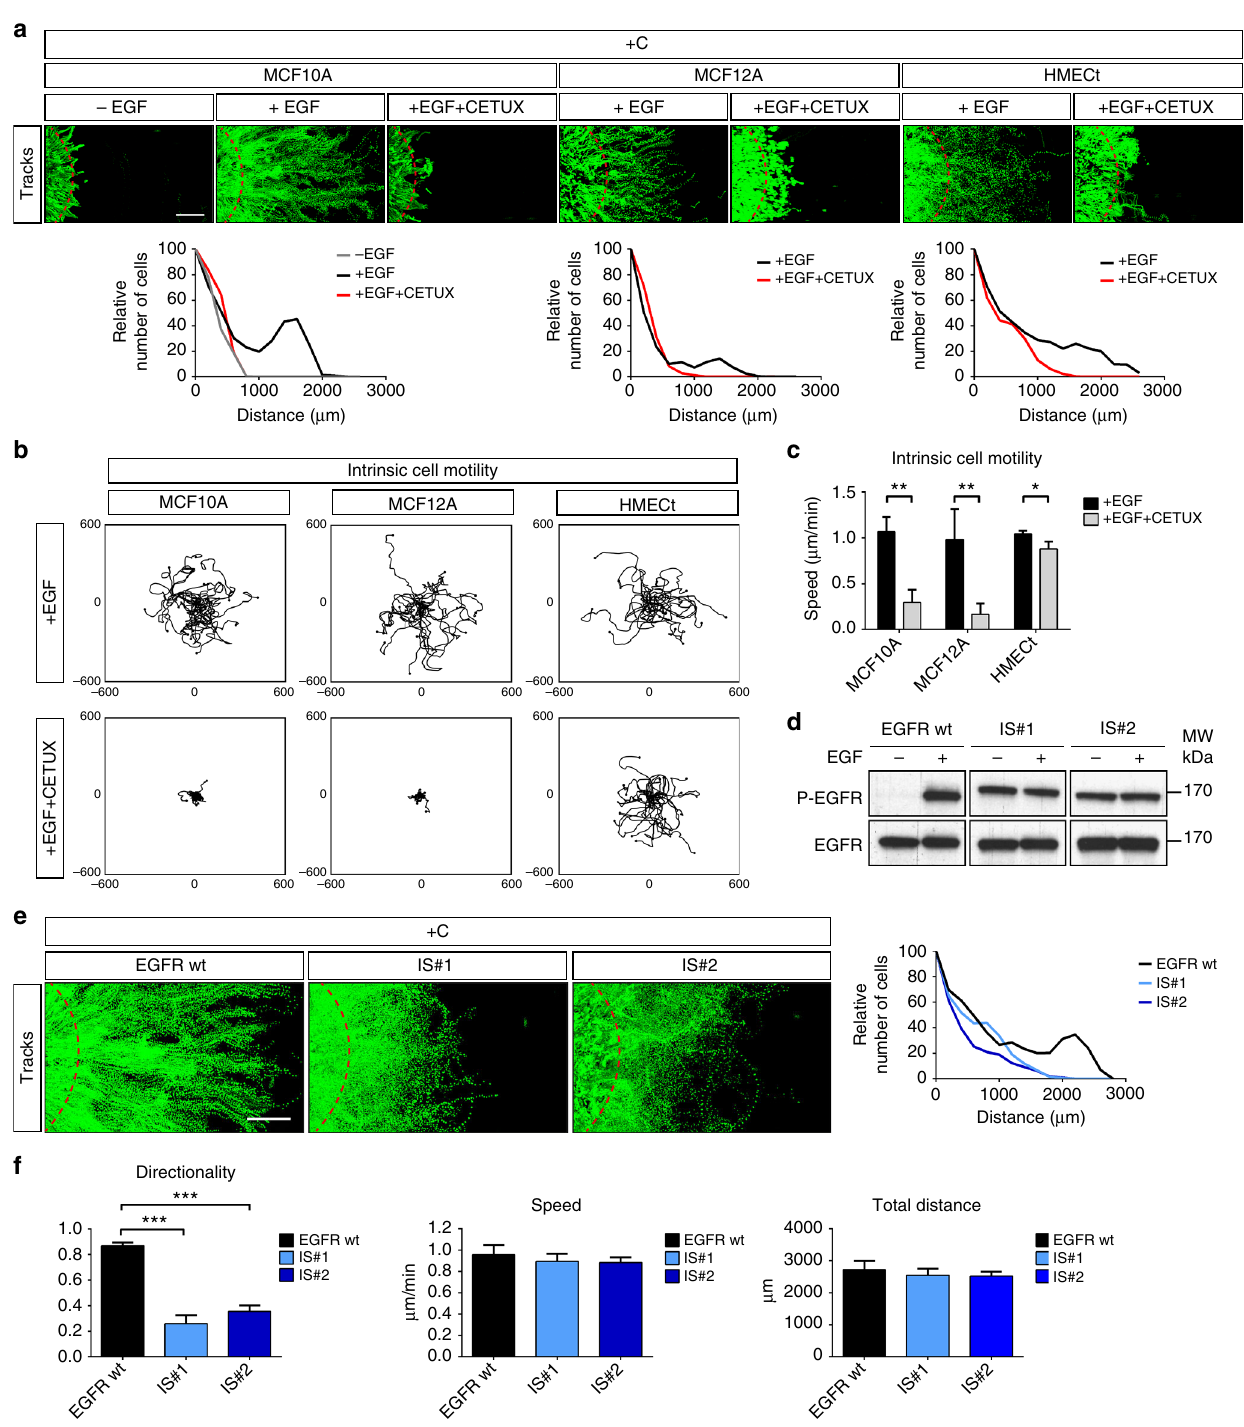
or phospho-EGFR-speci fi c antibodies con fi rmed that EGF sti- mulation triggered EGFR phosphorylation and endocytosis as demonstrated by immuno fl uorescence (Fig. 6a left panel). This process is dampened upon GSH or NAC treatment in several cell types (Fig. 6a, b, Supplementary Fig. 13). Conversely, oxidative stress, by incubation with H 2 O 2 , or continuous generation of low amount of exogenous H 2 O 2 by the Gaox (galactose/galactose oxidase) system or endogenous generation of H 2 O 2 by DMNQ (2,3-Dimethoxy-1,4-naphthoquinone) strongly potentiated the activation of EGFR, which corroborated the previously